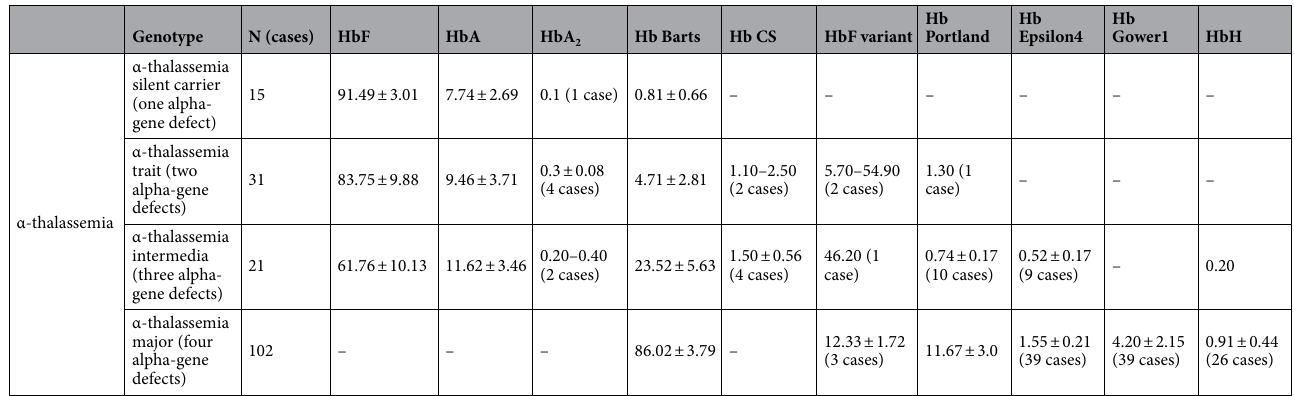
Table 2. Distribution of hemoglobin fractions presented in 169 α-thalassemia fetuses